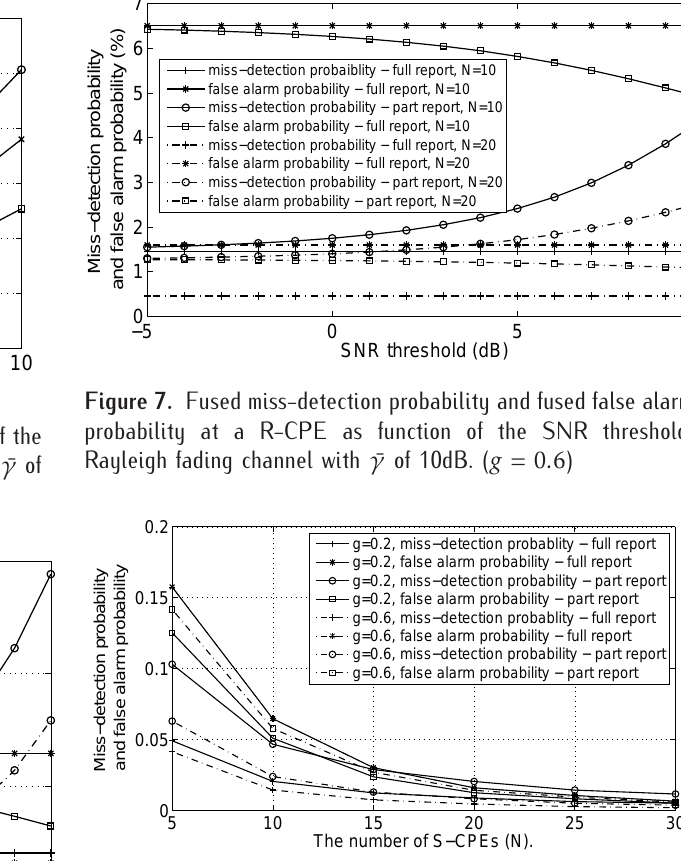
Figure 8. Fused miss-detection probability and fused false alarm probability at a R-CPE as function of the number of S-CPEs. Rayleigh fading channel with ¯ γ of 10 dB, γ